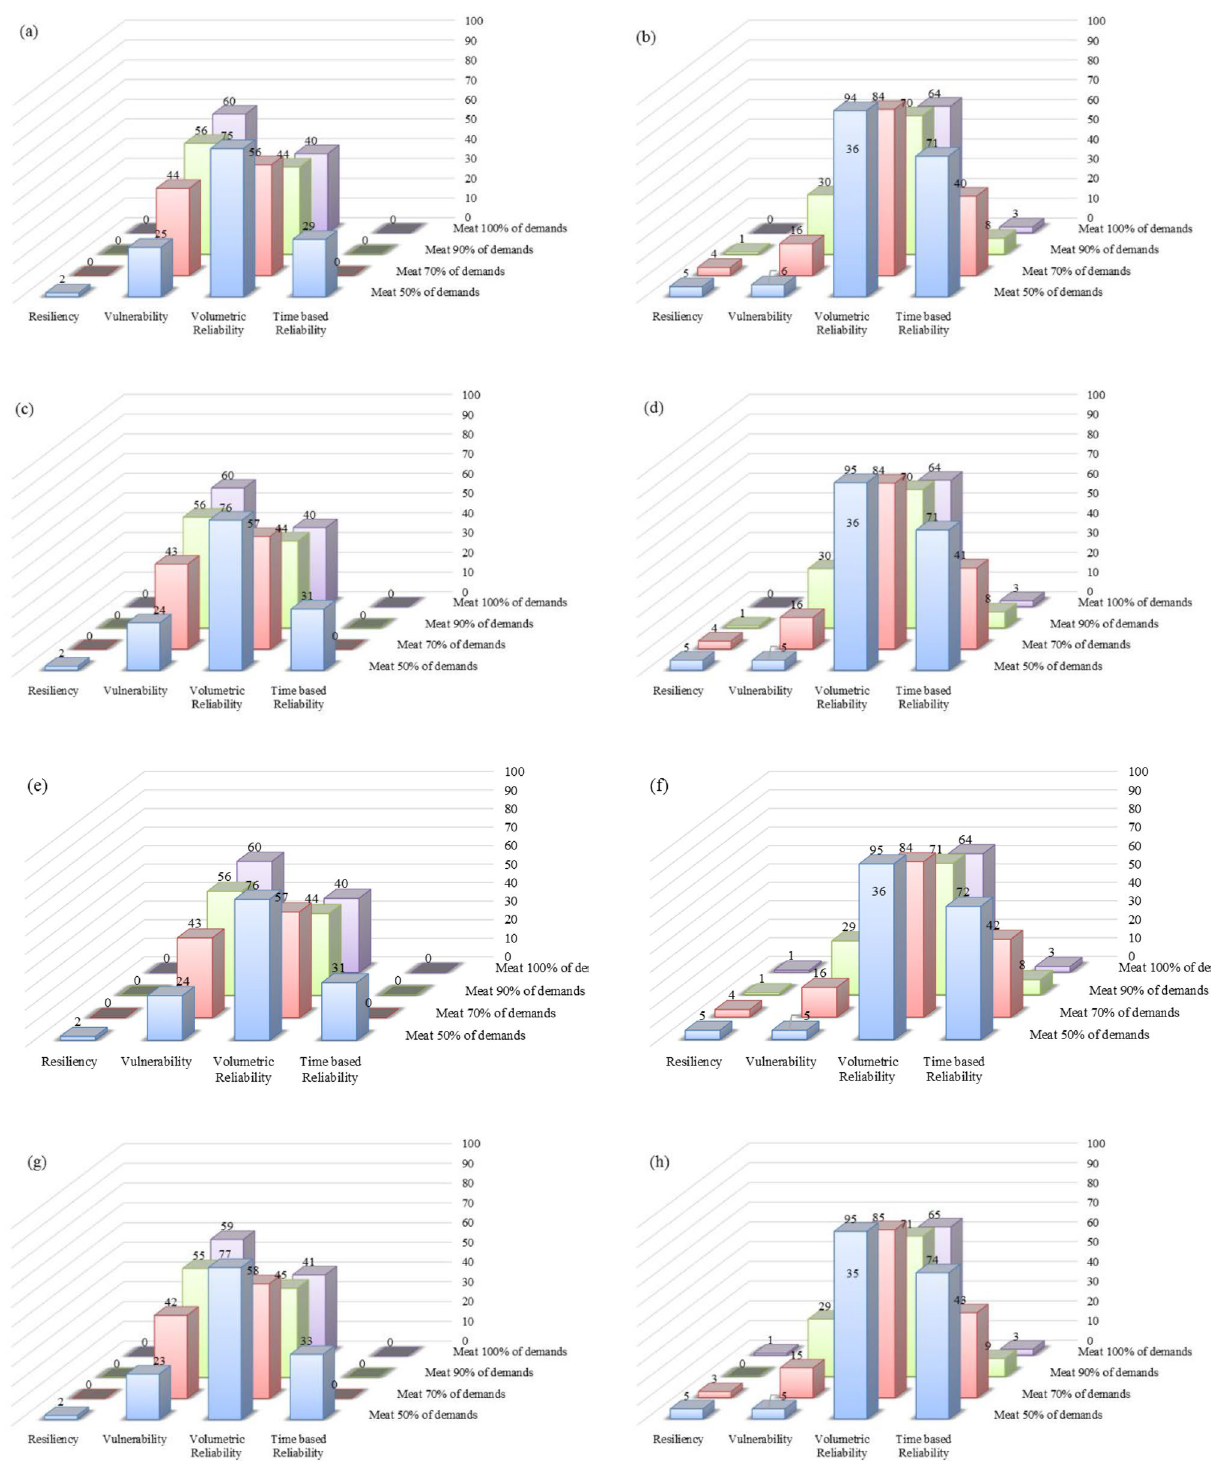
Figure 11. Performance criteria of the predicted lake volumes in future periods for Option 2 under six management scenarios: ( a ) management Scenario 1 in 2021–2050; ( b ) management Scenario 1 in